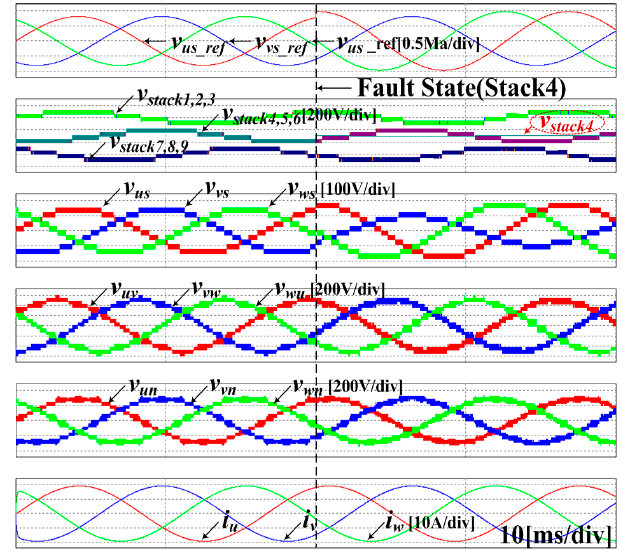
Figure 18. Simulation waveform when V phase fourth stack fails in applying the conventional neutral-point voltage-shifting control.